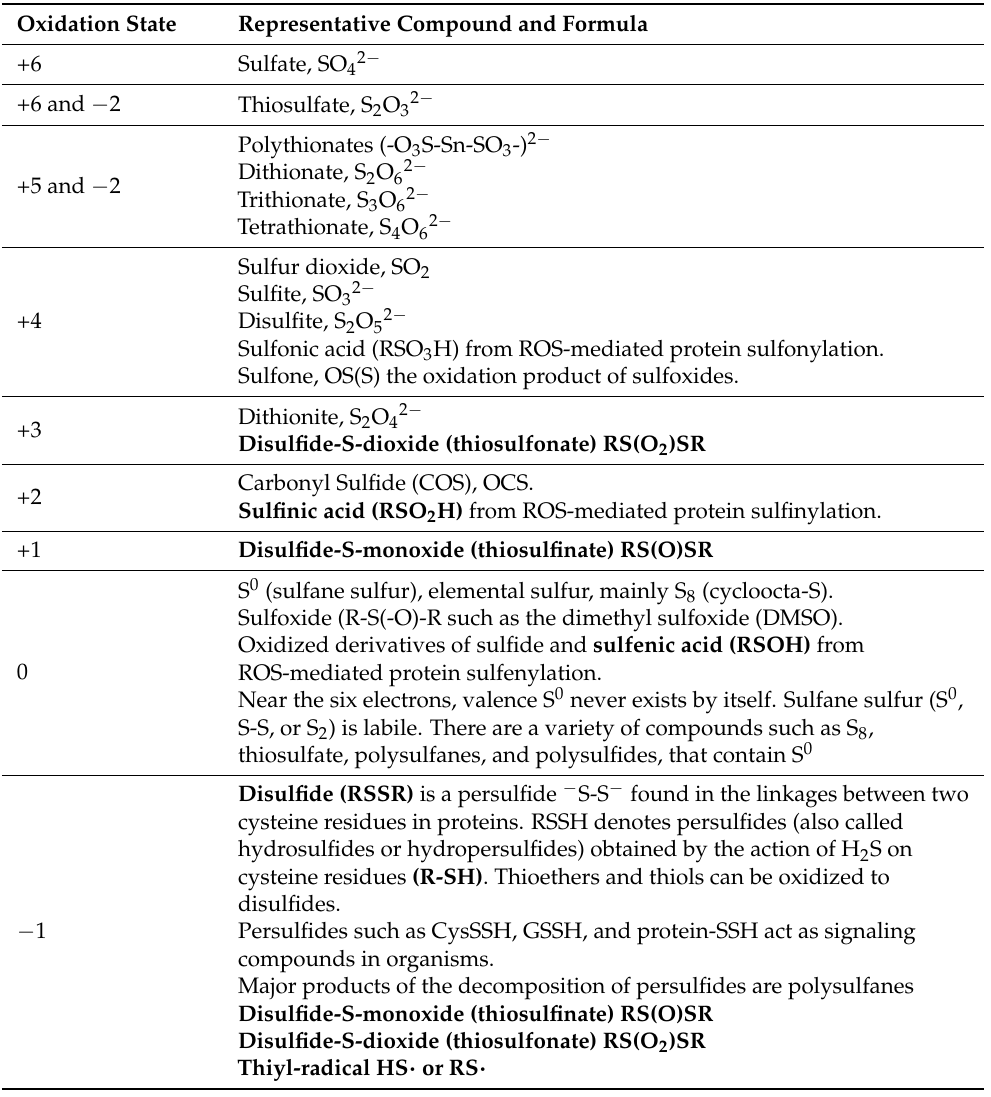
Table 3. Representative sulfur compounds and their oxidation state. RSS are in bold letters. Modified from